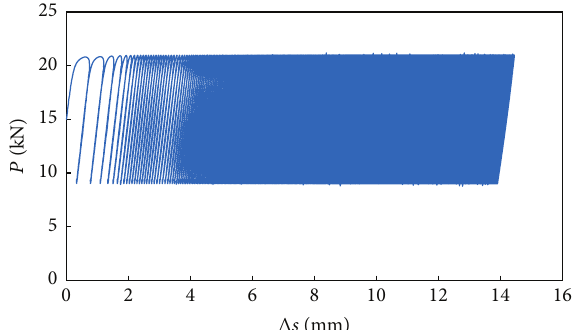
Figure 8: Cyclic load-displacement curve of model pile B (SLR = 0.30, CLR = 0.40).